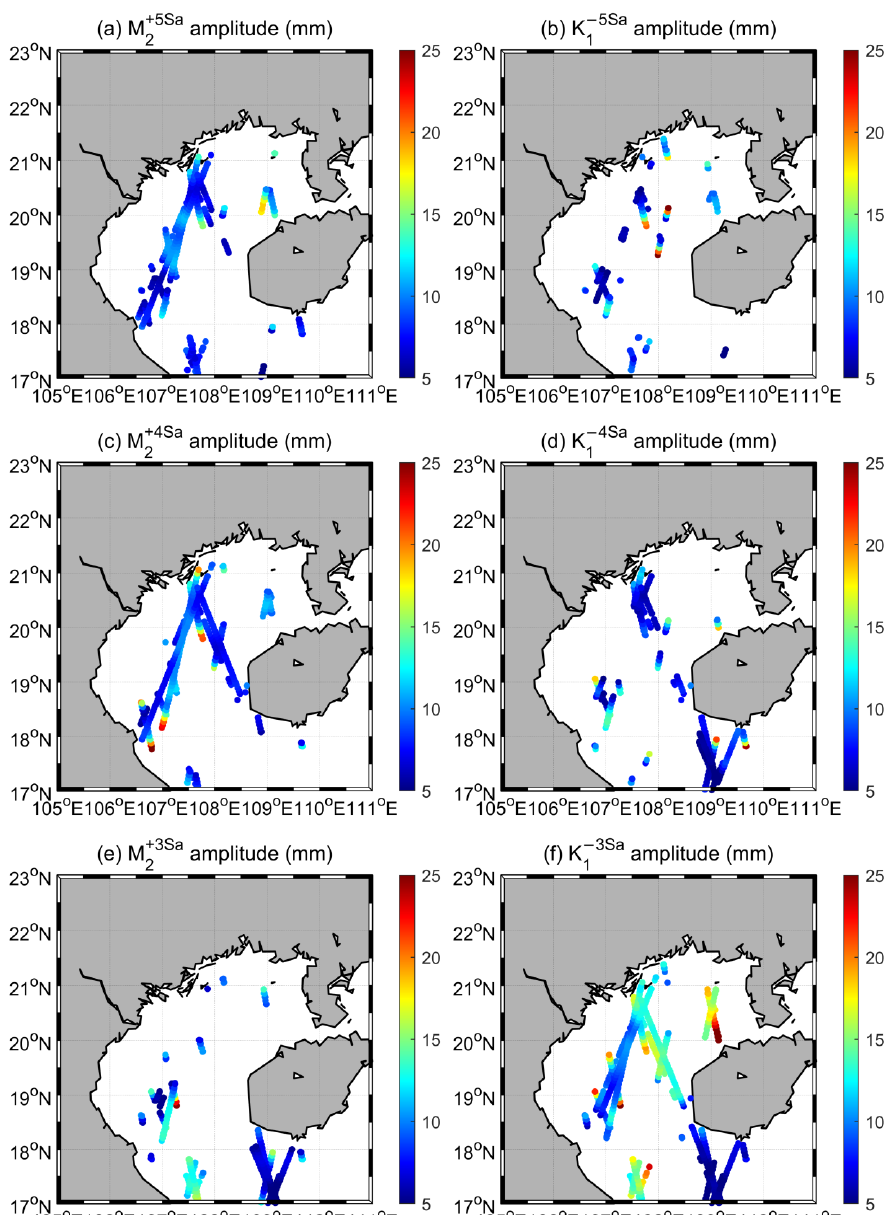
Figure 10. Estimated tidal amplitudes (unit: mm) in the Gulf of Tonkin from multi-satellite altimeter observations ( a ) M 2+5Sa ( b ) K 1 −5Sa ( c ) M 2+4Sa ( d ) K 1 −4Sa ( e ) M 2+3Sa ( f ) K 1 −3Sa . The spatially averaged amplitudes of M 2+5Sa , M 2+4Sa , M 2+3Sa , K 1 −5Sa , K 1 −4Sa , and K 1 −3Sa in the Gulf of Tonkin are 8.8 mm, 9.5 mm, 9.2 mm, 9.5 mm, 7.8 mm, 11.3 mm, respectively. Compared to M 2+5Sa and M 2+3Sa , M 2+4Sa has the largest mean amplitude and the maximum number (411) of observation points which have valid amplitudes. The largest M 2+4Sa amplitude can reach 31.8 mm in the south of the Gulf of Tonkin (Figure 10c). Compared to K 1 − 5Sa and K 1 − 4Sa , K 1 − 3Sa has the largest mean amplitude and the maximum number (603) of observation points which have valid amplitudes. The largest K 1 − 3Sa amplitude can reach 31.3 mm in the east of the Gulf of Tonkin (Figure 10f). In summary, the features of subseasonal variations in M 2 , K 1 , and O 1 tides in the Gulf of Tonkin are distinct. The strongest subseasonal cycles in M 2 , K 1 , and O 1 tides are the quarter-annual, ter-annual, and penta-annual cycles,